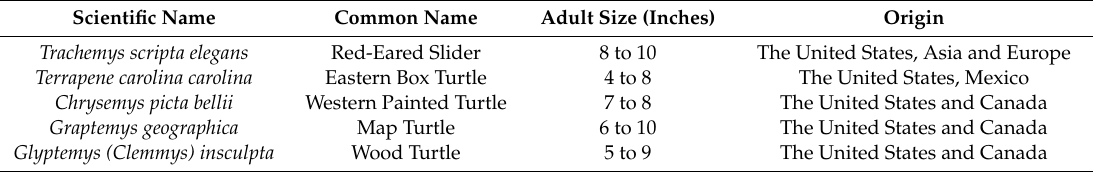
Table 1. Most popular pet turtles according to the Reptiles